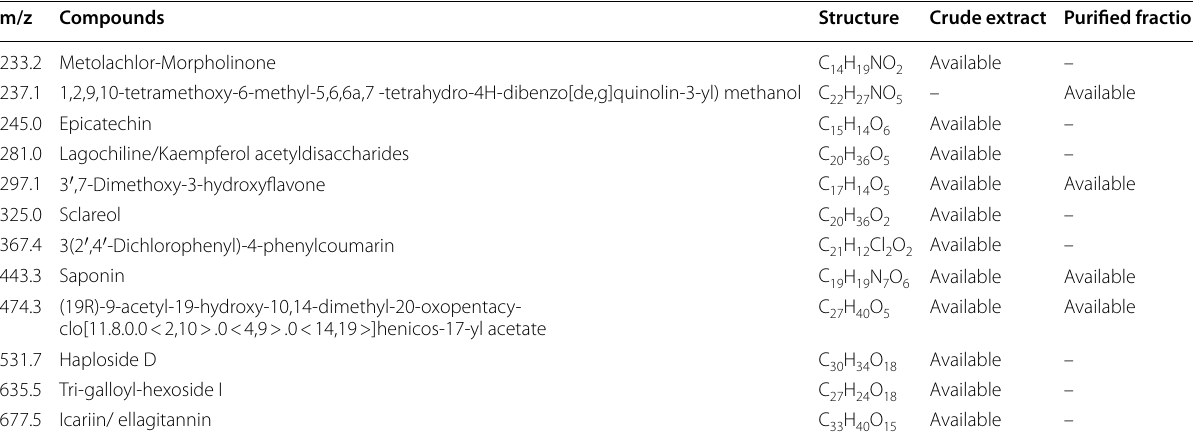
Table 5 Phytochemicals profiling of crude and purified leaf extracts of S. maritima m/z Compounds 233.2